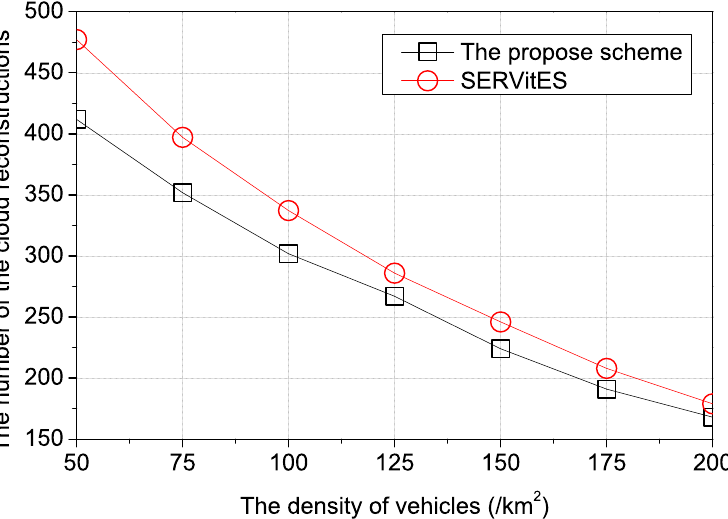
Figure 8. The number of the cloud reconstructions according to the density of